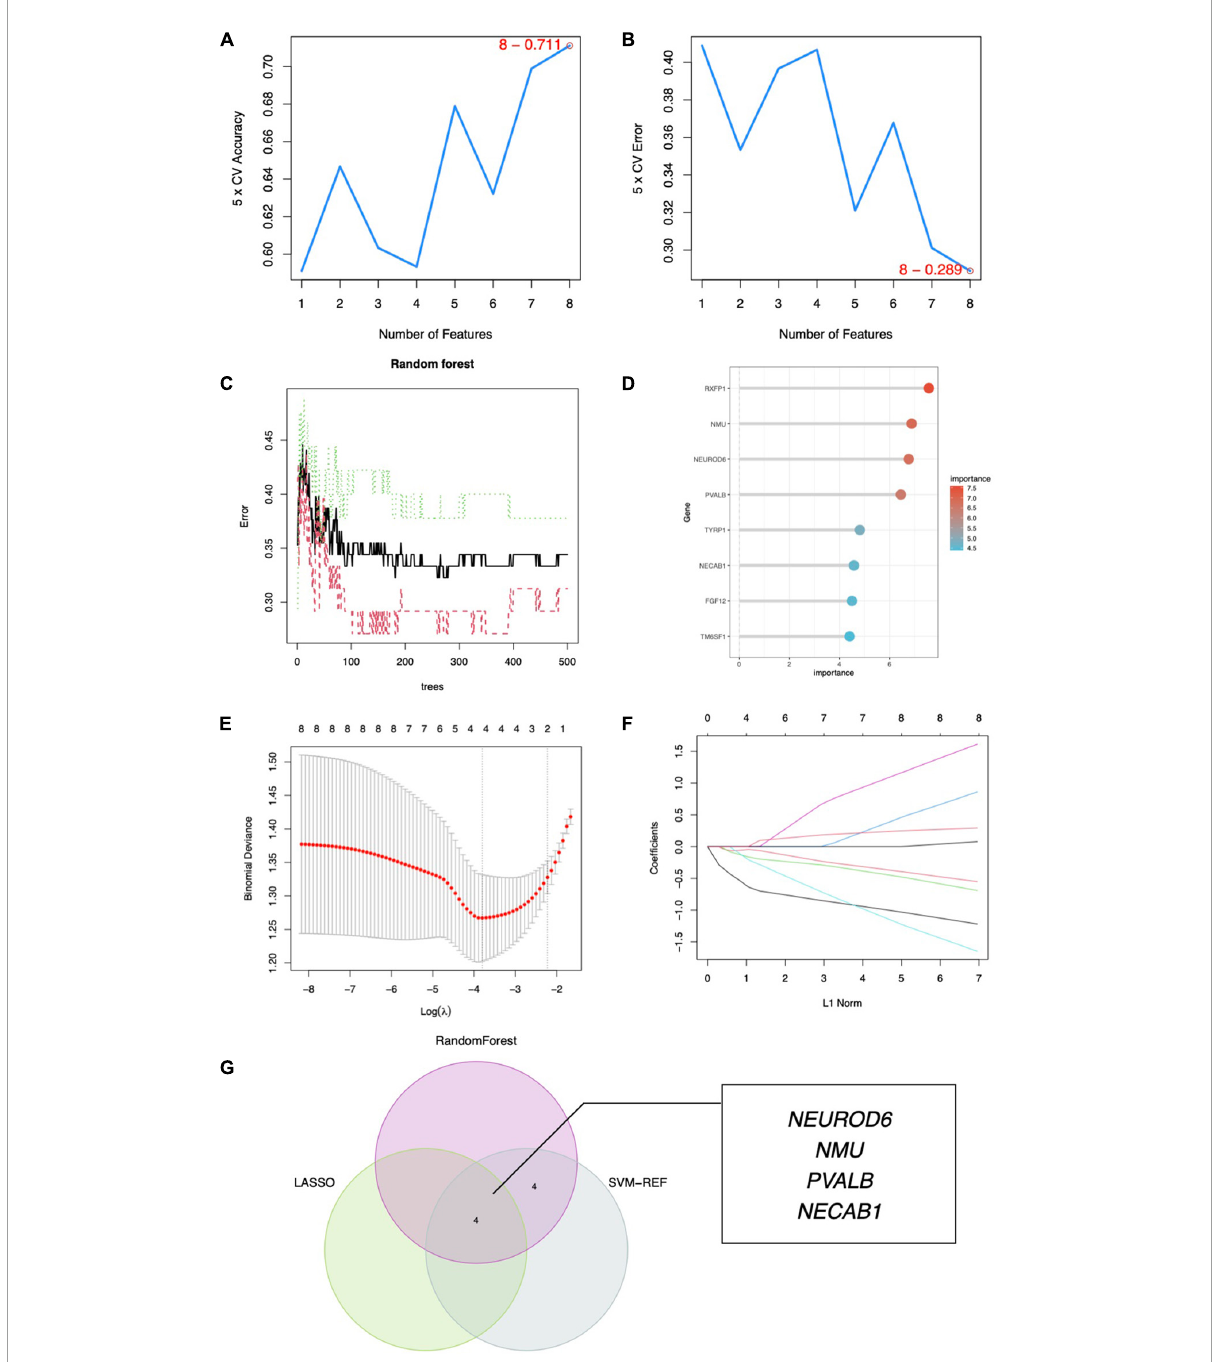
FIGURE6 Hub gene identification. (A) Eight gene signatures were identified by SVM-RFE analysis with an accuracy of 0.711. (B) Error of 0.289. (C) Prediction accuracy of the RF model. (D) Gene importance scores of RF model. (E) Cross-validation to select the optimal tuning parameter log (Lambda) in LASSO regression analysis. (F) LASSO coefficient profiles of candidate genes. (G) Venn diagram of four hub genes shared by the SVM-RFE, RF, and LASSO algorithms.